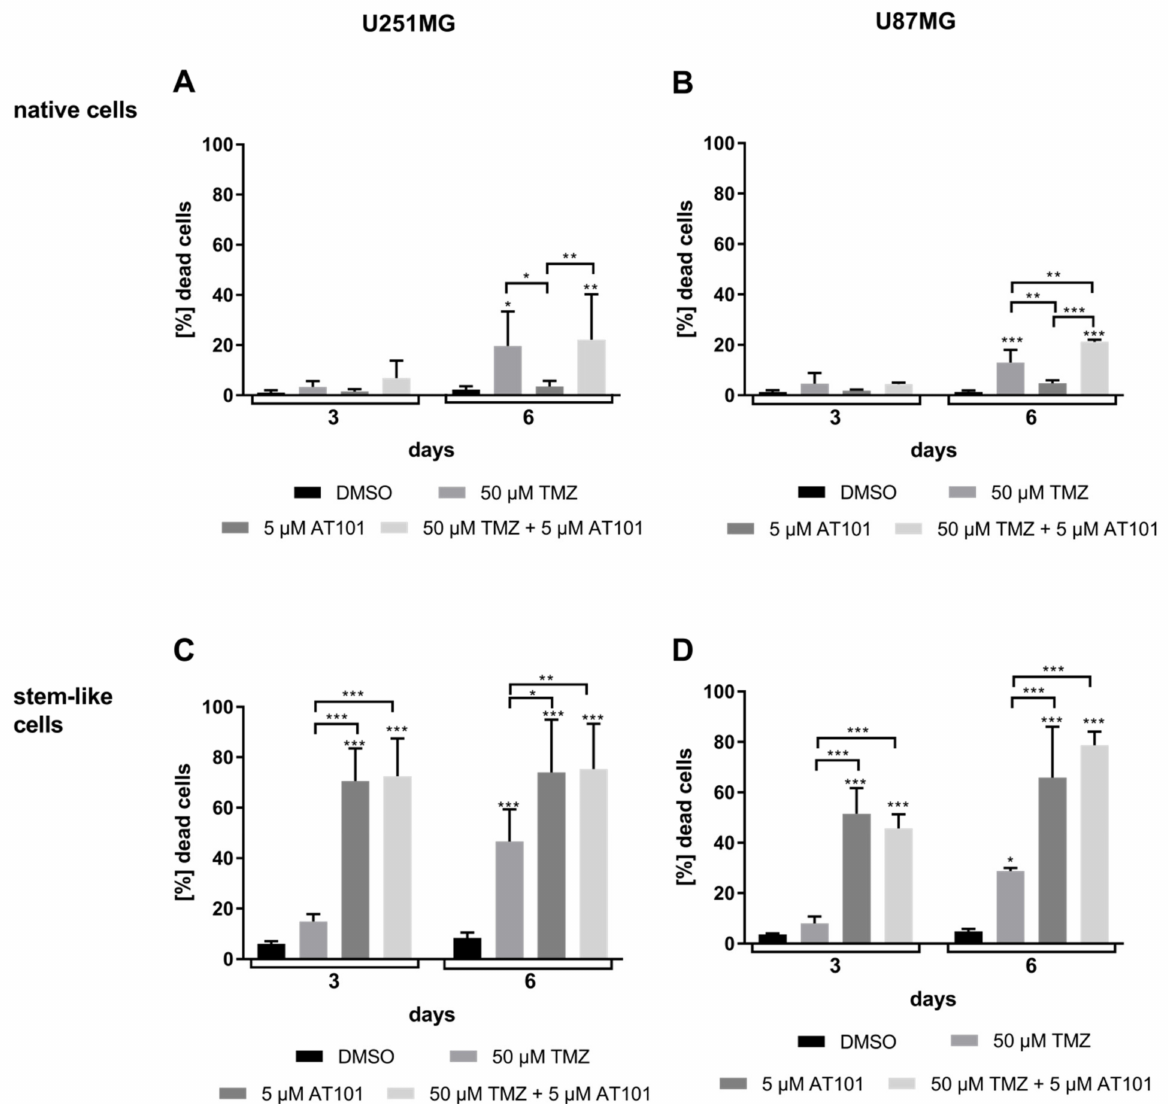
Figure 1. AT101 affected the survival of stem-like U251MG and U87MG glioblastoma (GBM) cells to a greater extent compared to native GBM cells. After stimulation with dimethyl sulfoxide (DMSO) (control), temozolomide (TMZ) [50 µ M], AT101 [5 µ M], or TMZ [50 µ M] and AT101 [5 µ M], a cytotoxicity assay was carried out after three and six days, respectively. Death rates of native ( A ) U251MG and ( B ) U87MG cells, as well as of stem-like ( C ) U251MG and ( D ) U87MG cells are depicted. The significances between different stimulation approaches were determined with a two-way analysis of variances (ANOVA) test followed by a Tukey’s multiple comparison test. Significant differences compared to the DMSO control are indicated directly above the bars and between different stimulations on a line linking the bars (* p < 0.05; ** p < 0.01; *** p < 0.001). Error bars correspond to the standard deviation, n =